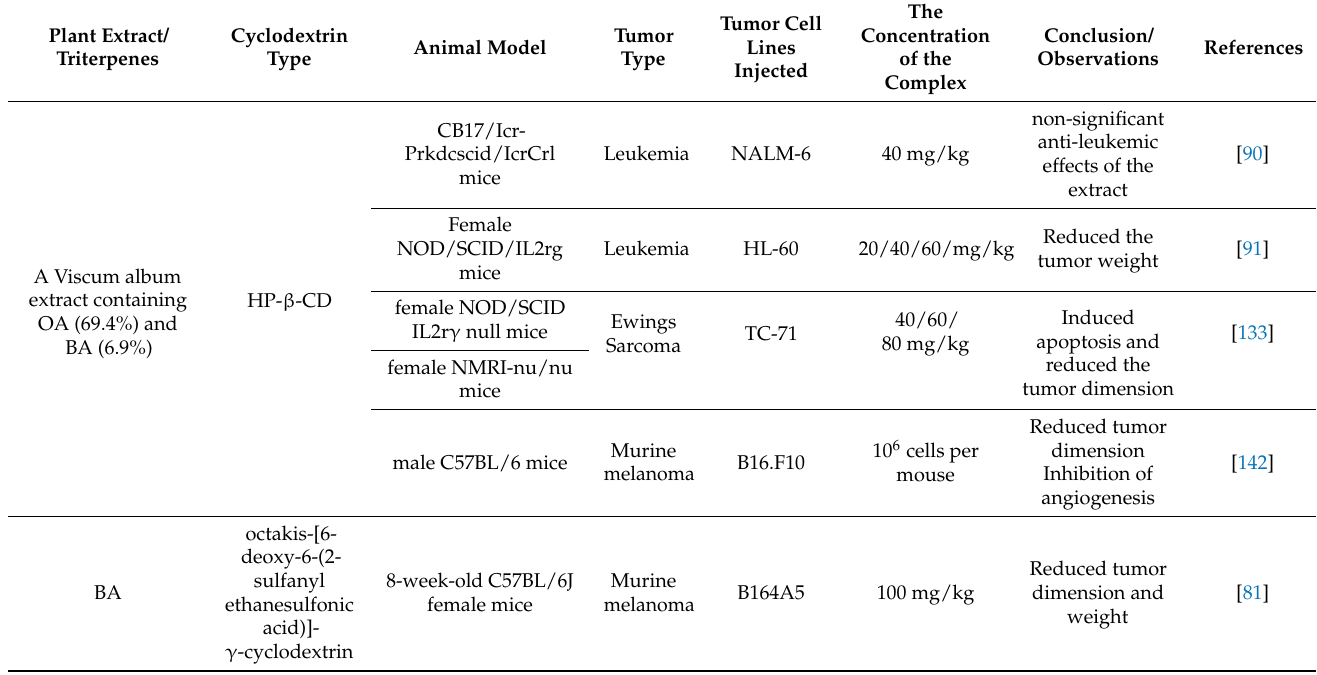
Table 7. In vivo anticancer activity of triterpene:cyclodextrin inclusion complexes.